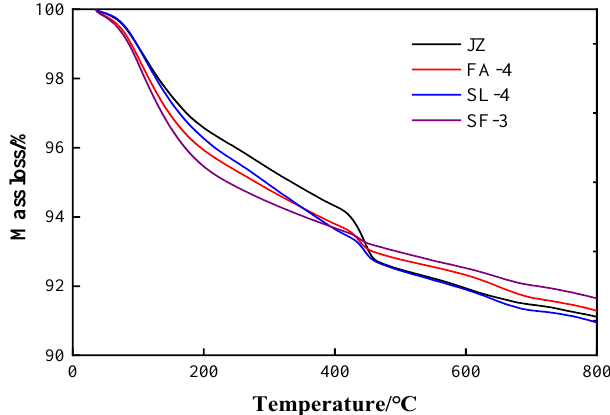
Figure 11. TG curve of cement mortar slurry.